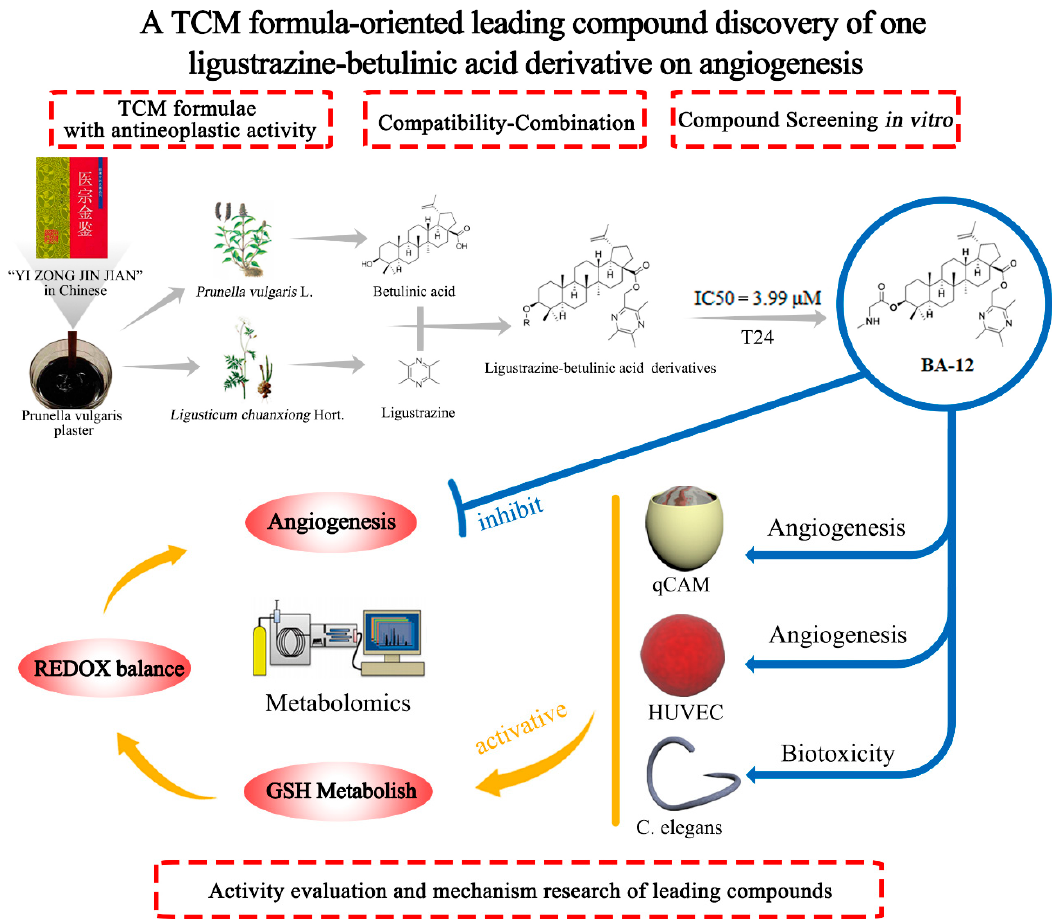
Figure 1. The leading compound discovery strategy based on the compatibility theory of traditional Chinese medicine and the combination principle of pharmacochemistry.